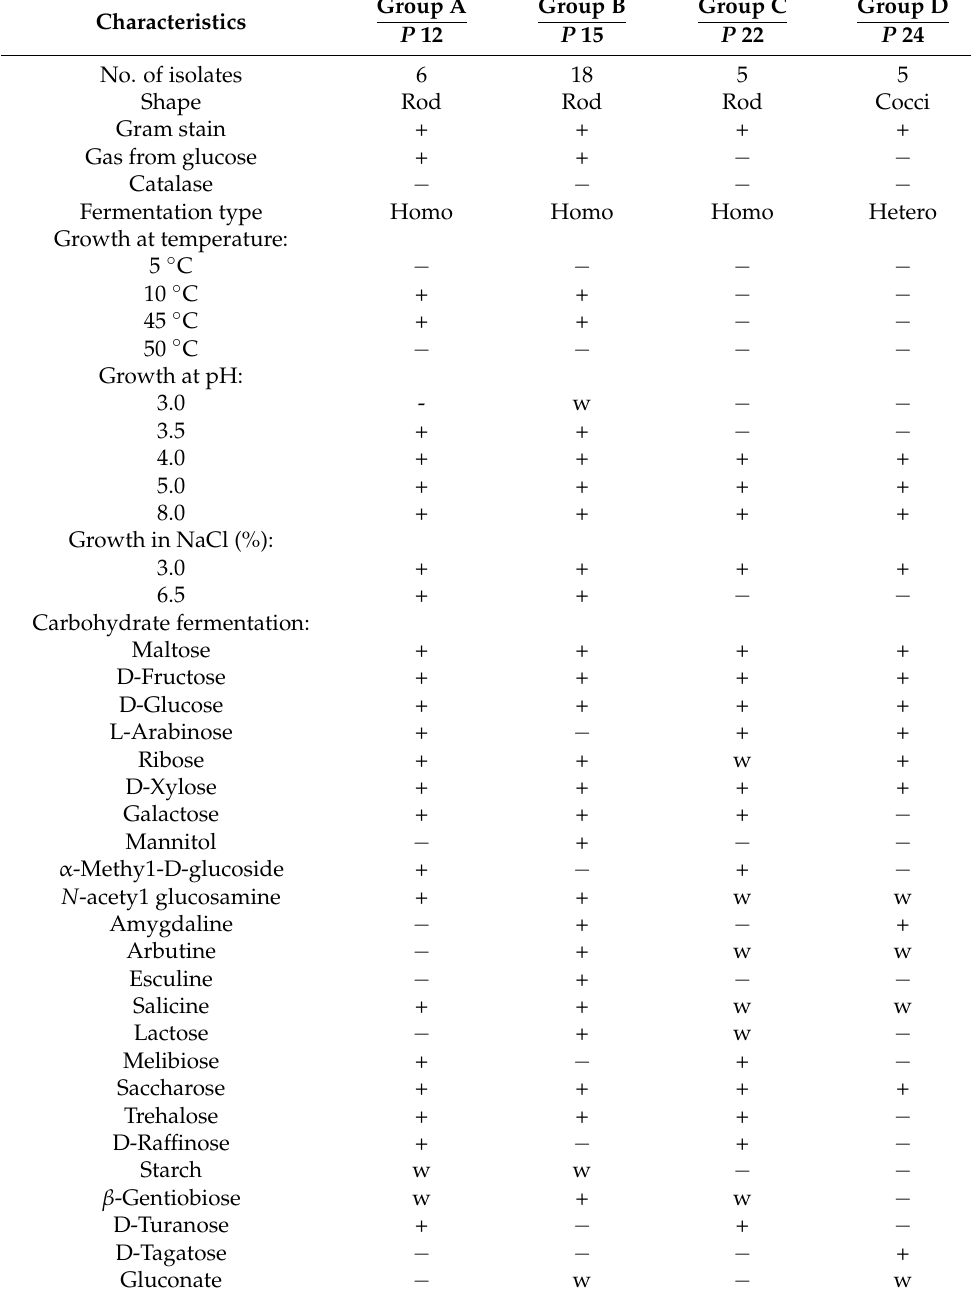
Table 2. The characteristics of isolated strains from pineapple residue